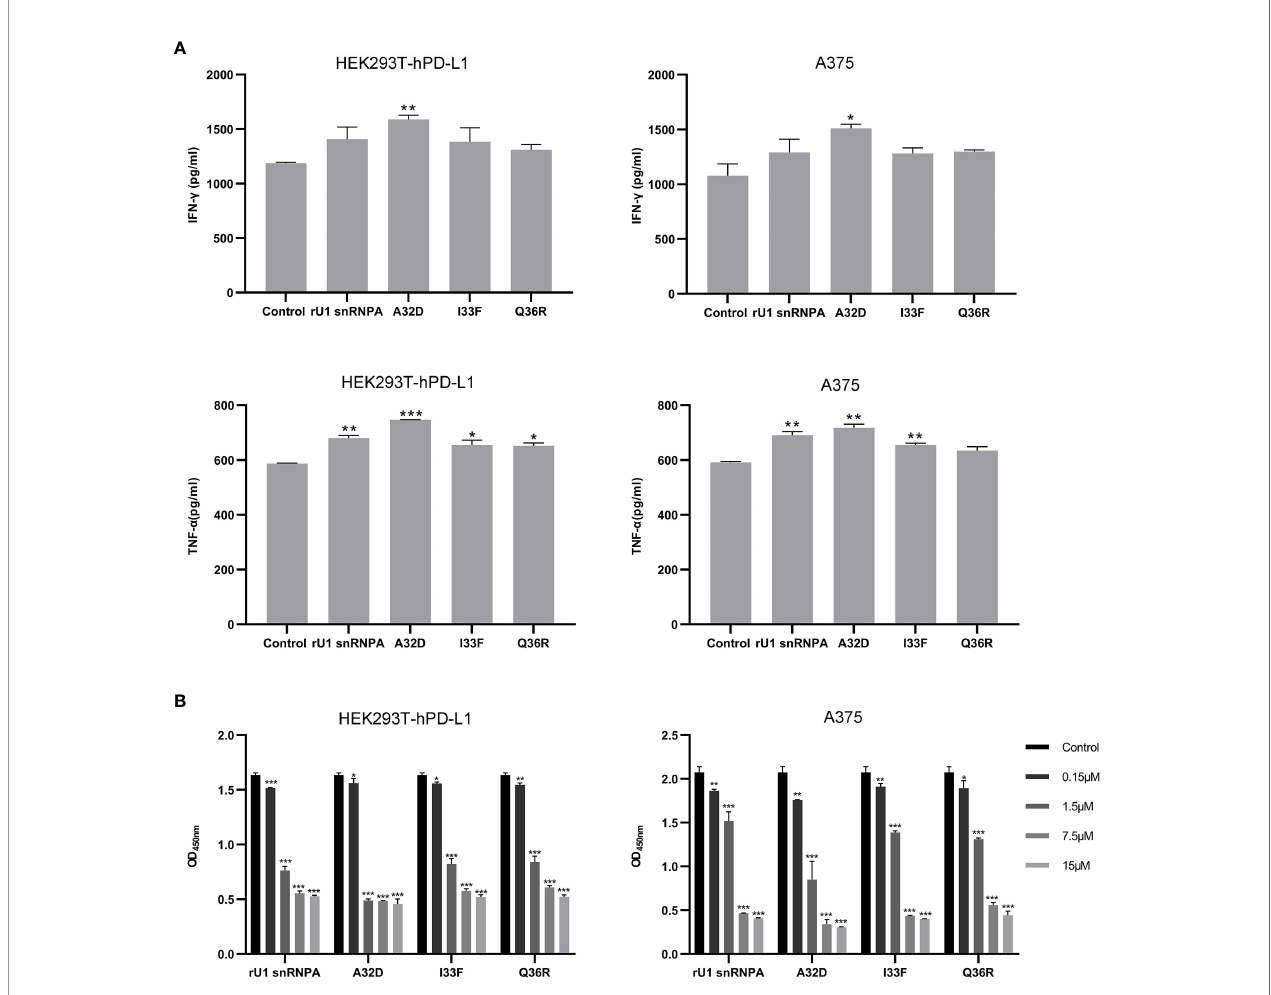
FIGURE 8 | Effect of variants on T cell reactivation function and anti-melanoma ef fi cacy. (A) Effect of variants on IFN- g and TNF- a secretion from CD4+ T cells co- cultured with HEK293T-hPD-L1 cells or A375 cells. (B) Anti-melanoma ef fi cacy of variants mixed with CD4+ T cells in HEK293T-hPD-L1 cells or A375 cells. Data are shown as mean ± SD. *P < 0.05, **P < 0.01, ***P <